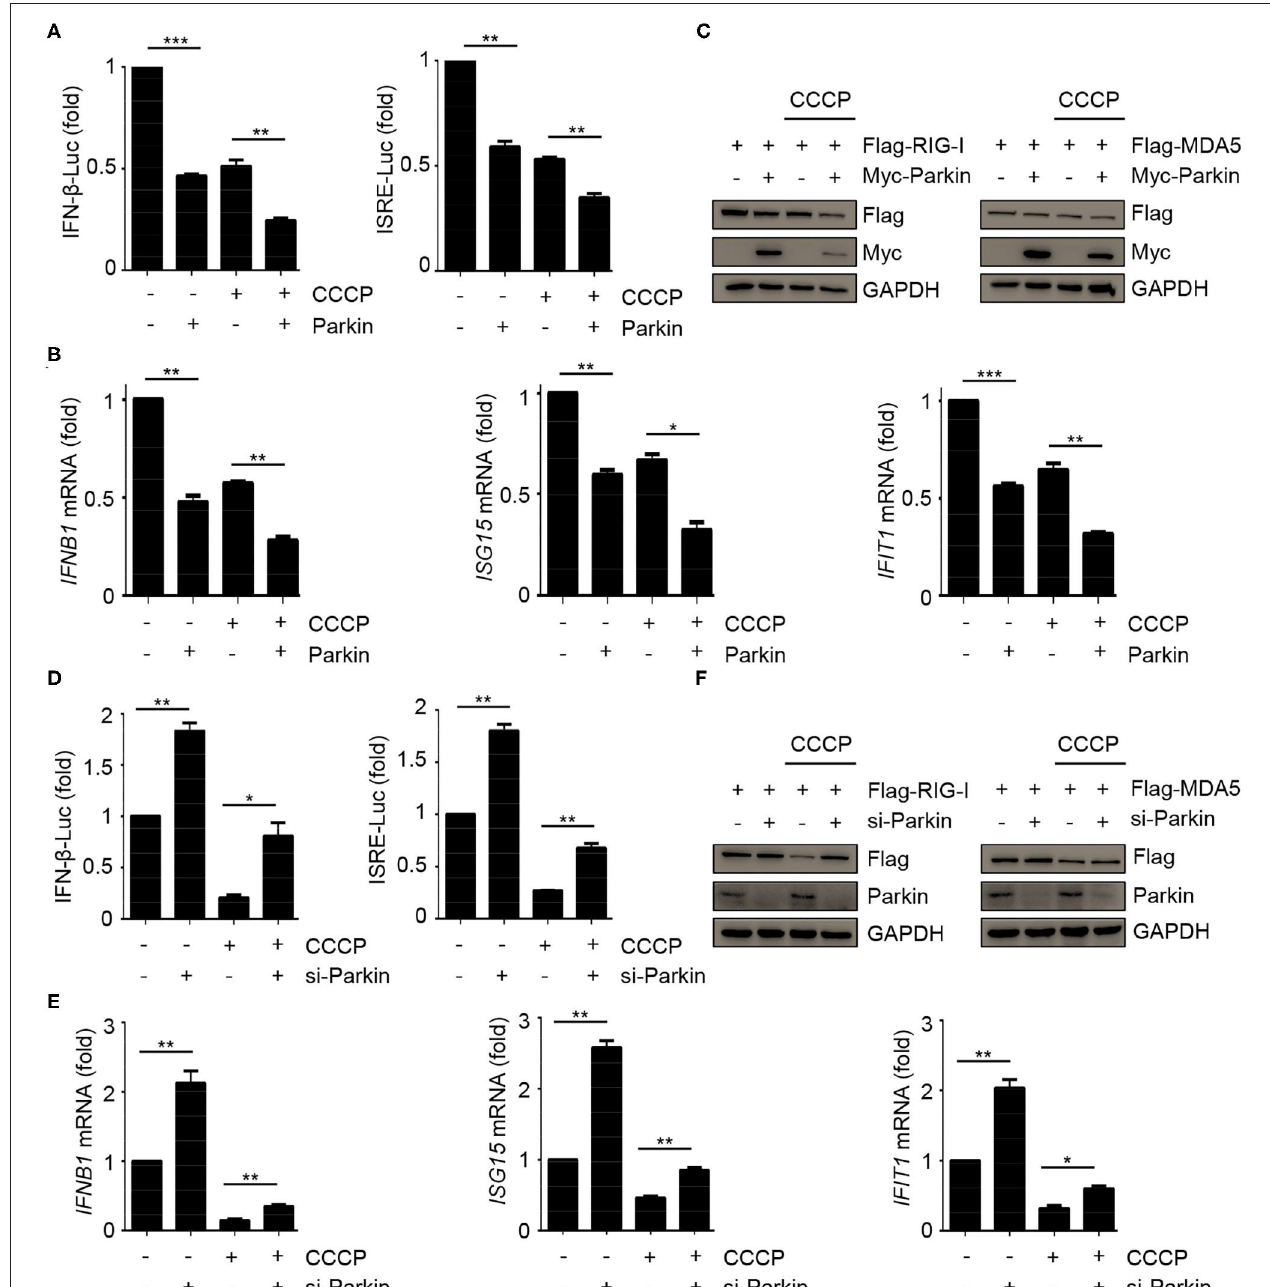
FIGURE 3 | Parkin promotes the inhibition of CCCP on innate immunity. (A) HEK293 cells were co-transfected with vector or Parkin and IFN- β or ISRE luciferase reporter for 24h, untreated or treated with CCCP (10 µ M) for 2h, then stimulated with SeV for 10h, and subjected to luciferase assays. (B) HEK293 cells were transfected with vector or Parkin for 24h, untreated or treated with CCCP (10 µ M) for 2h, then stimulated with SeV for 10h, and subjected to quantitative RT-PCR analysis. (C) 293T cells were co-transfected with Flag-RIG-I or Flag-MDA5 and vector or Myc-Parkin for 24h, untreated or treated with CCCP (10 µ M) for 12h, and the whole cell extracts were subjected to IB analysis. (D) HEK293 cells were co-transfected with si-control or si-Parkin and IFN- β or ISRE luciferase reporter for 48h, untreated, or treated with CCCP (10 µ M) for 2h, then stimulated with SeV for 10h, and subjected to luciferase assays. (E) HEK293 cells were si-control or si-Parkin for 48h, untreated or treated with CCCP (10 µ M) for 2h, then stimulated with SeV for 10h, and subjected to quantitative RT-PCR analysis. (F) 293T cells were co-transfected with Flag-RIG-I or Flag-MDA5 and si-control or si-Parkin for 48h, untreated or treated with CCCP (10 µ M) for 12h, and the whole cell extracts were subjected to IB analysis. The data represent the average of three independent experiments and were analyzed by unpaired t- test. All data represent the mean ± S.D. * p < 0.05, ** p < 0.01, and *** p < 0.001.